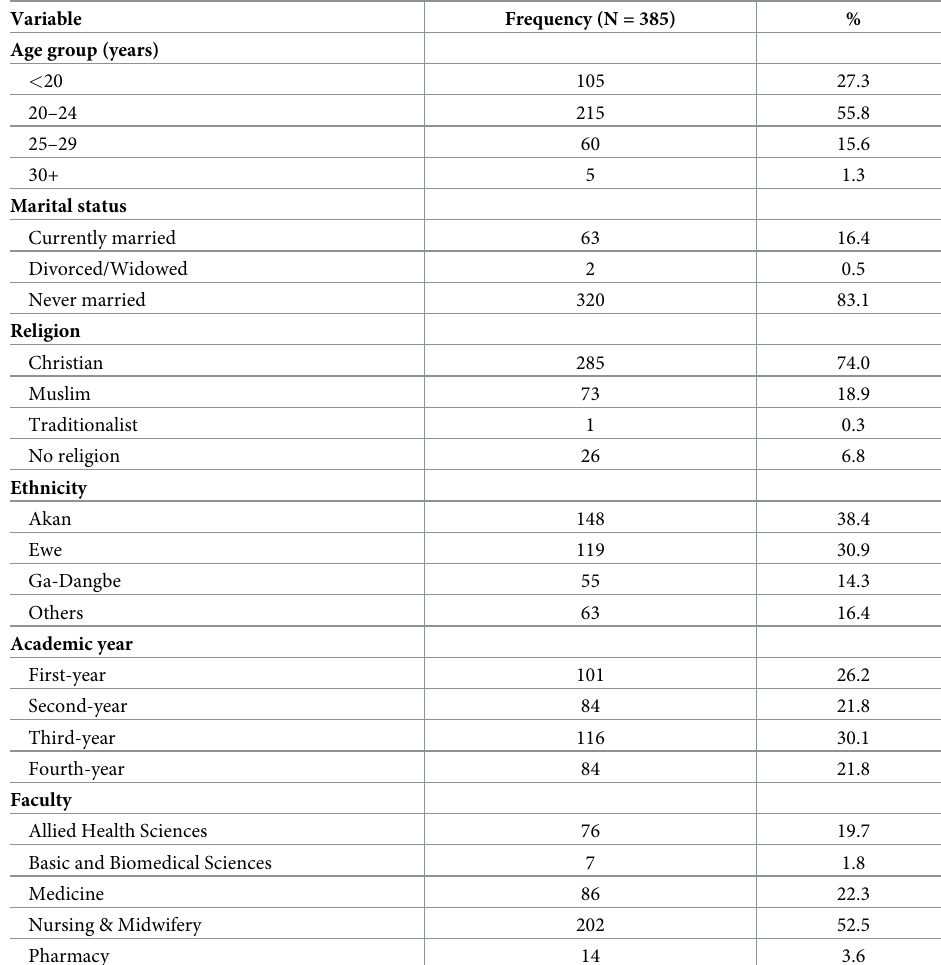
Table 2. General characteristics of